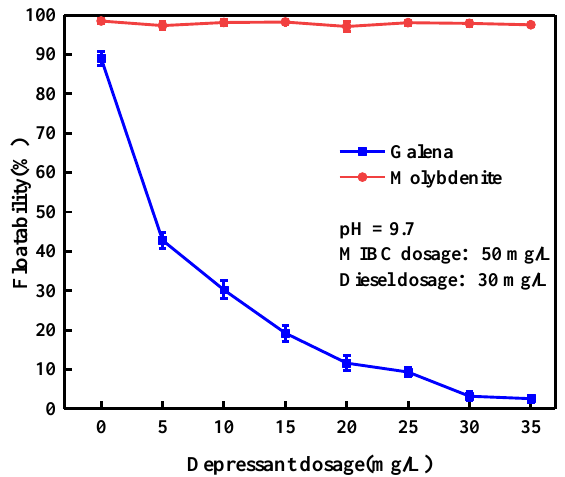
Figure 3. Floatability of galena and molybdenite as a function of depressant dosage.